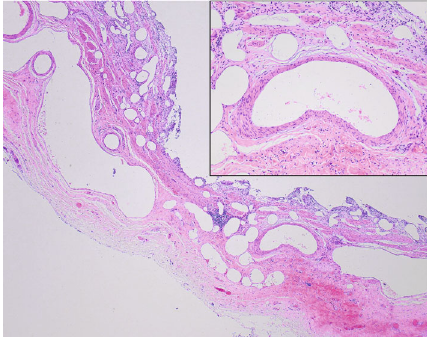
Figure 1: Representative photomicrograph of angiodysplasia of the gallbladder. Low-power magni fi cation shows reduced and wide mucosal folds with cylindrical epithelia of the mucosa almost entirely missing. There was a moderate mixed in fl ammatory cell in fi ltrate in the submucosa, and the muscular layer was slightly hypertrophic, which is consistent with chronic cholecystitis. An interesting fi nding was large, dilated, and malformed arteries and veins in the distorted muscular layer extending into the submucosa and mucosa. (HE; 40x). The inset microphotograph shows a large thick artery from the submucosa of the wall of the gallbladder body (HE; 200x).